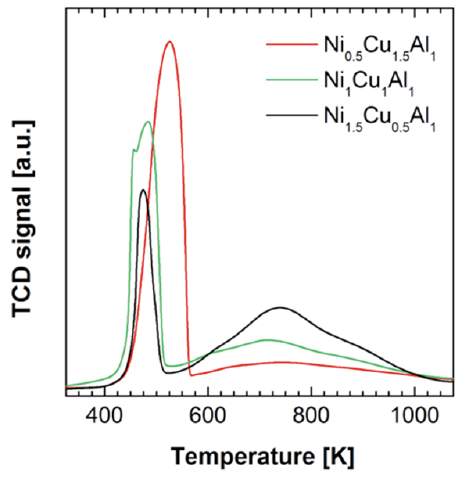
Table 4. Specific hydrogen consumptions during TPR of calcined LDH samples.